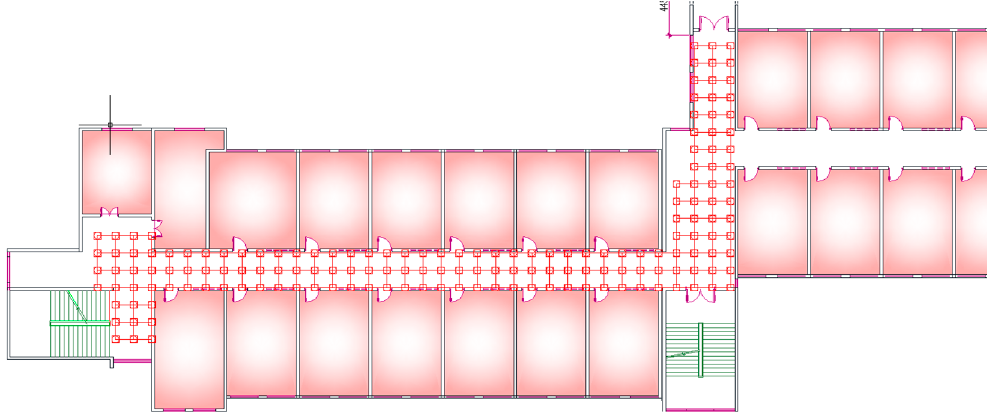
Figure 2. Experimental environment and the distribution of reference points on one floor.